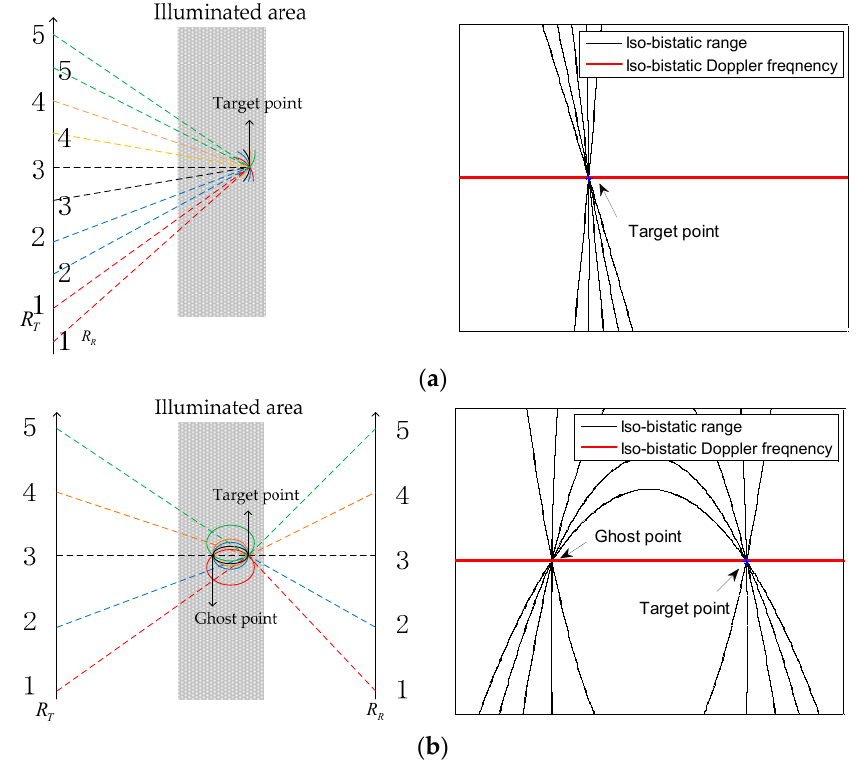
Figure 4. The range histories of the backward bistatic ( a ) and forward bistatic ( b ) at target P during full aperture and the numbers 1 to 5 represent different positions of the transmitter and receiver at the azimuth direction. The right column is the zoom of the target imaging scene of the left column.